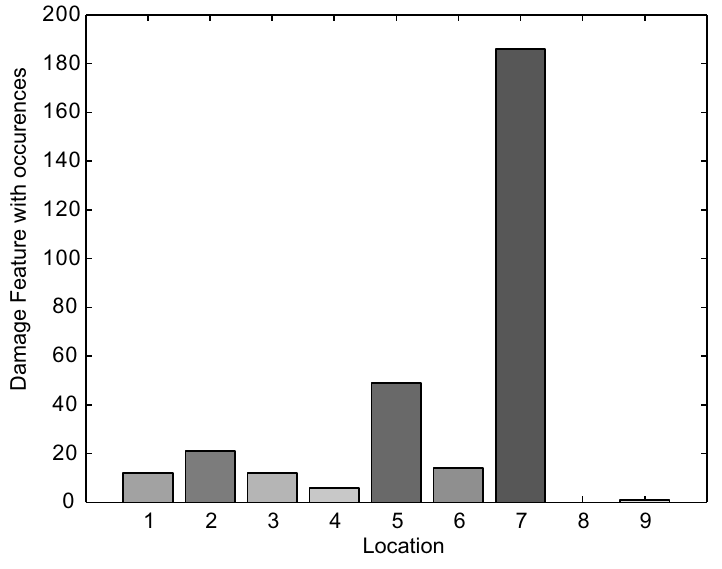
Fig. 7. Damage feature with occurrences, frequency range 10–40 Hz.